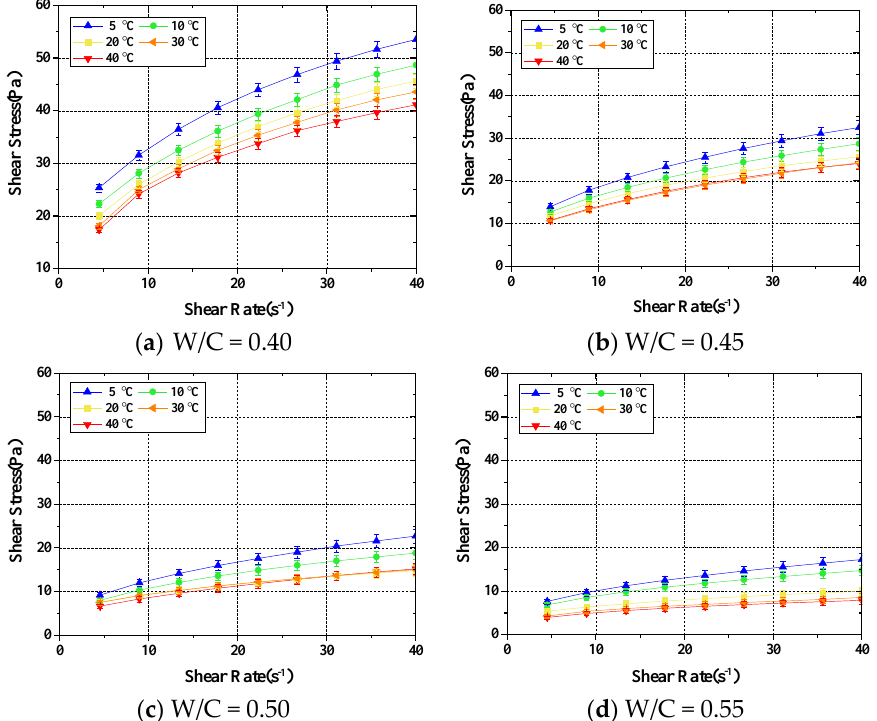
Figure 2. The test results of the rheological properties for different cement paste mixing ratios.